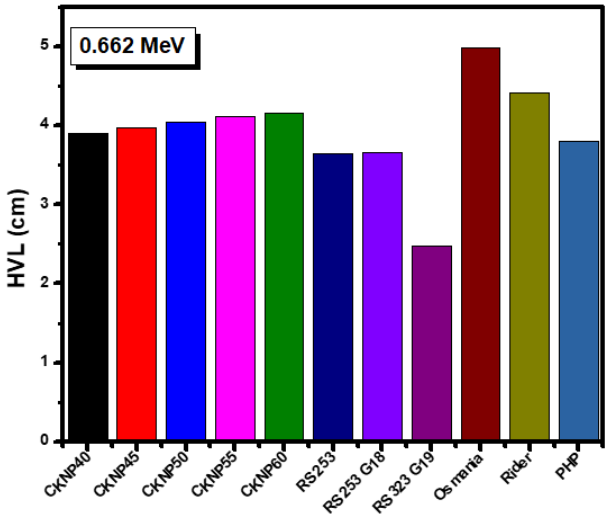
Figure 7. Comparison between the HVL for the tested glasses with other shielding glasses.